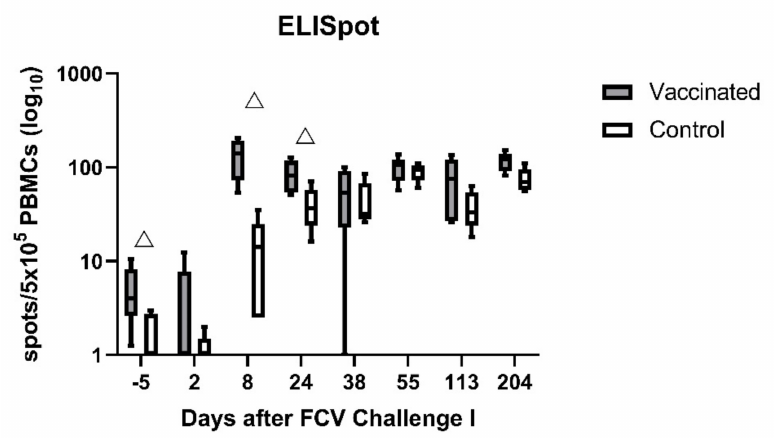
Figure 10. Box and whisker plots of IFN- γ -releasing PBMCs after stimulation with the challenge virus FCV 273. The line inside the box shows the median, and the lower and upper border of the box indicates the 25th and 75th percentile, respectively. Whiskers represent minimum and maximum values. Significant differences between the vaccinated and the control group are indicated with an open triangle; (cid:52) denotes significantly higher in the vaccinated group P MWU ≤ 0.05.